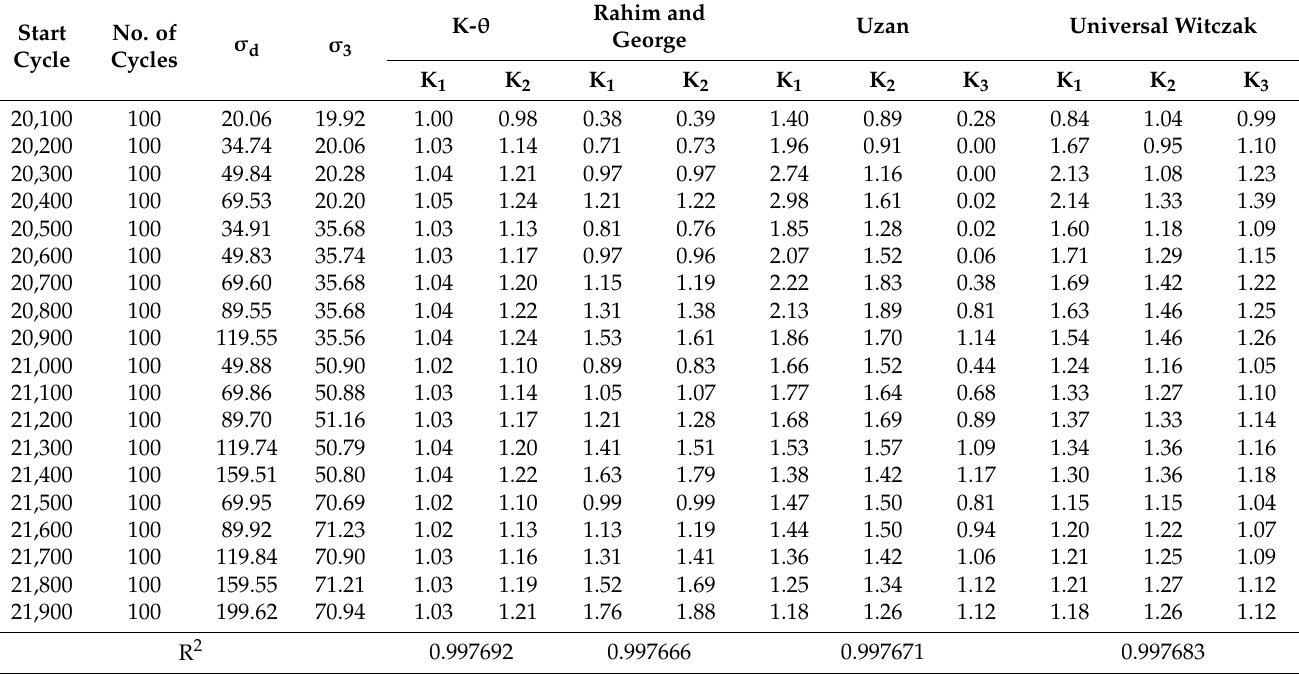
Table 4. Determination of models’ average regression coefficients for specimen SP3.